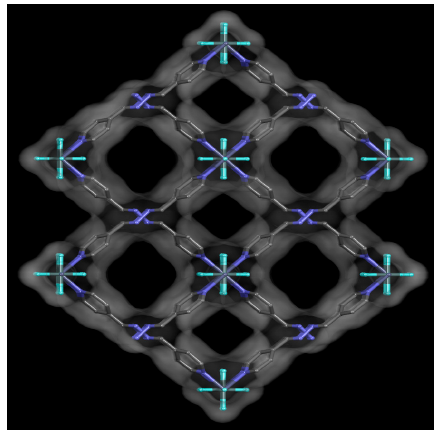
Figure 3. Packing diagram showing potential voids of framework. Color: Grey—C, Light Blue—N, Blue—Zn, Light green—Chlorine.